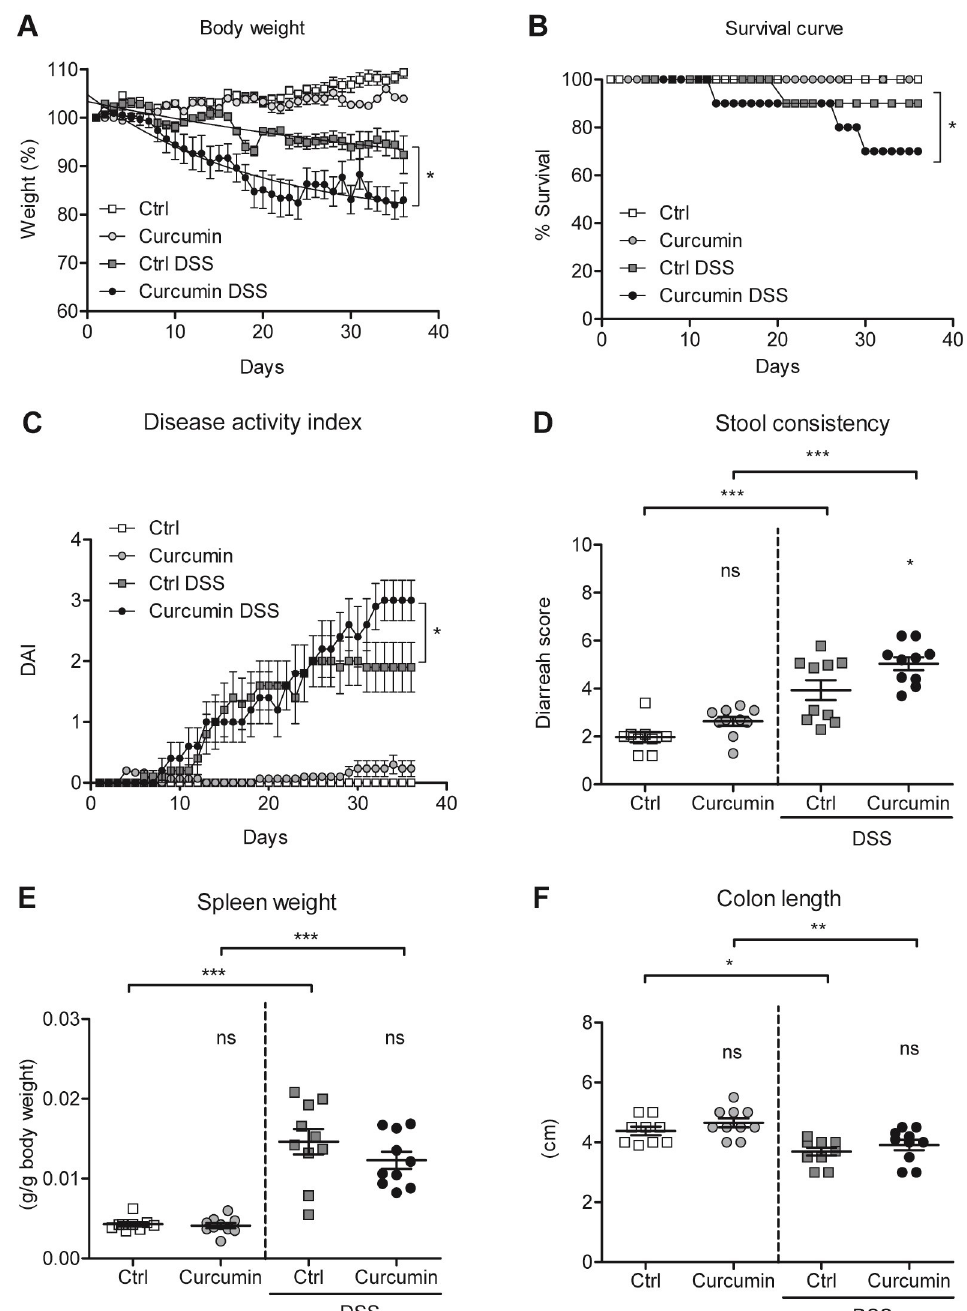
Fig 2. Curcumin supplementation of an iron-sufficient diet aggravates colitis in a DSS-mouse model. C57BL/6 mice were fed an iron-sufficient diet (Ctrl) or iron-sufficient diet supplemented with curcumin (Curcumin). For dextran sodium sulfate (DSS) treatment, mice were fed an iron-sufficient diet with or without curcumin, starting 2 weeks before administration of DSS. (A) Body weight. (B) Survival. (C) Disease activity index (DAI). (D) Stool consistency. (E) Spleen weight. (F) Colon length. Results are representative of a minimum of three independent experiments; n = 9–10 mice per group. Statistical analysis was performed with one-way ANOVA. � P < 0.05, �� P < 0.01, ��� P < 0.001, and ns = not significant between Curcumin to Ctrl groups and when indicated between non-DSS and DSS groups.